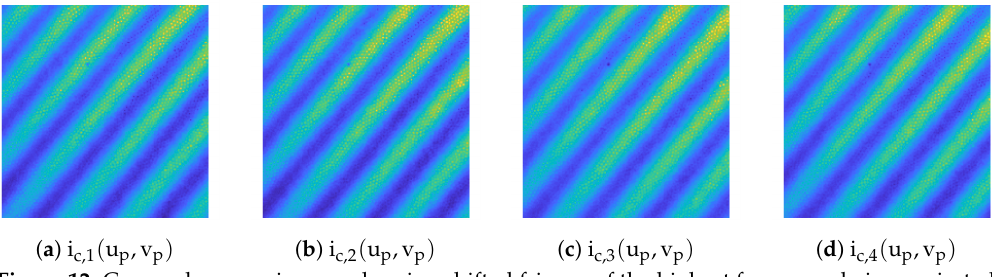
Figure 12. Cropped camera images showing shifted fringes of the highest frequency being projected onto a